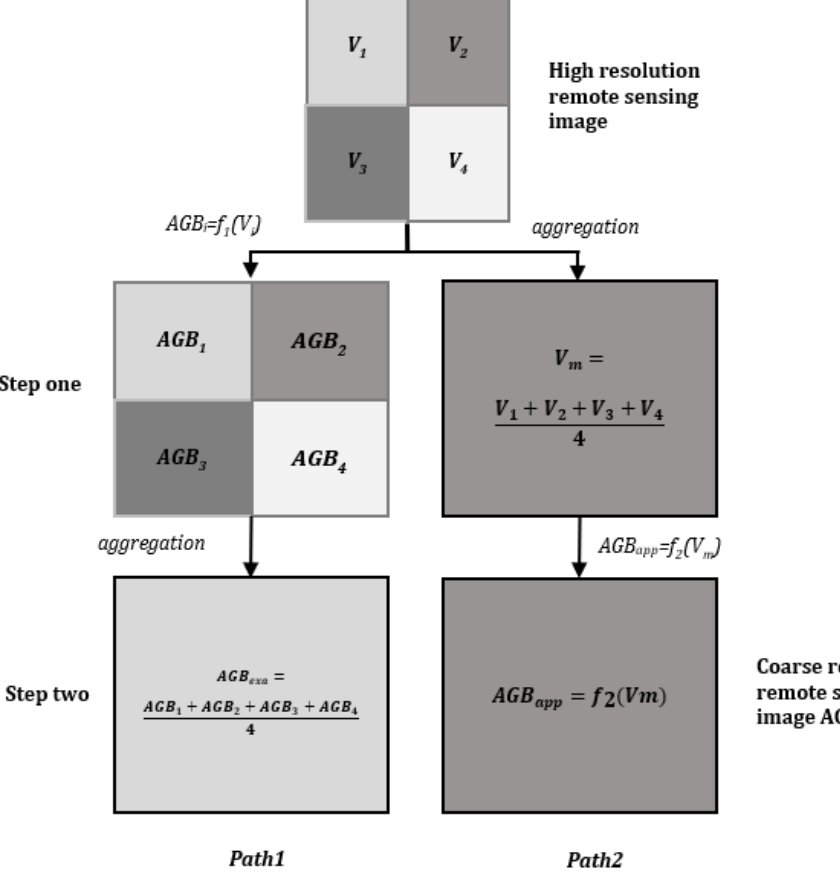
Figure 2. Schematic flowchart of the two upscaling methods of the AGB estimation. ( f i is the remote sensing inversion model of forest aboveground biomass; V ( i = 1,2,3,4 ) is the characteristic variable of the high-resolution remote sensing image; V m is the average value of V i , namely the pixel V value of the coarse-resolution image; AGB exa is the biological value of the high-resolution image, namely the relative truth value; AGB app is the biological value of the coarse-resolution image, namely the biological values with scale errors).